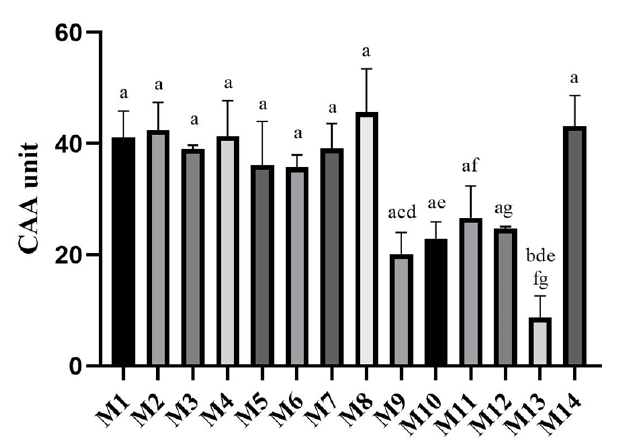
Figure 2. Cellular antioxidant activity as CAA values of all pomegranate peels ( n = 2). Different letters within each column indicate statistically significant differences at p < 0.05 in an ANOVA + Tukey’s pairwise t -test